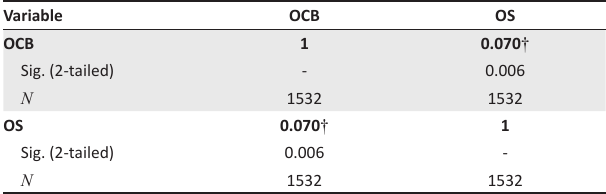
TABLE 2: Summary of Pearson’s correlation analysis showing the relationship between occupational stress and organisational citizenship behaviour. Variable